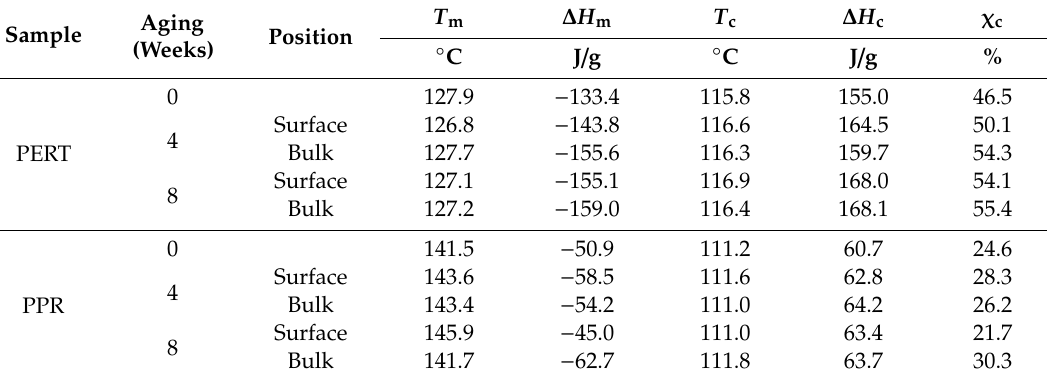
Table 2. Thermal data obtained via di ff erential scanning calorimetry (DSC) on PERT and PPR pipes. Sample